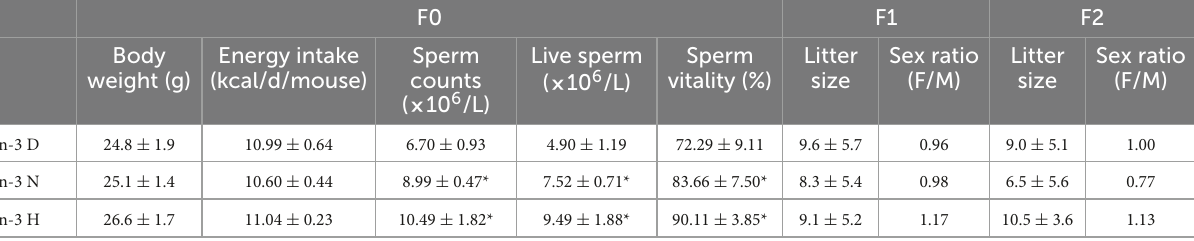
TABLE 2 Effects of paternal n-6: n-3 PUFAs on body weight and reproduction in themselves (F0). F0 F1 F2 Body Energy intake weight (g) (kcal/d/mouse)